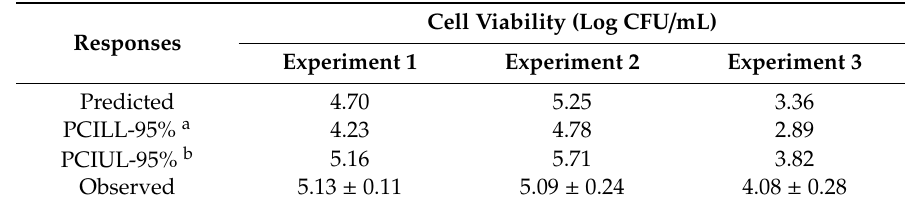
Table 2. Comparison between predicted and observed values for cell viability of the three experiments tested for validation of the regression